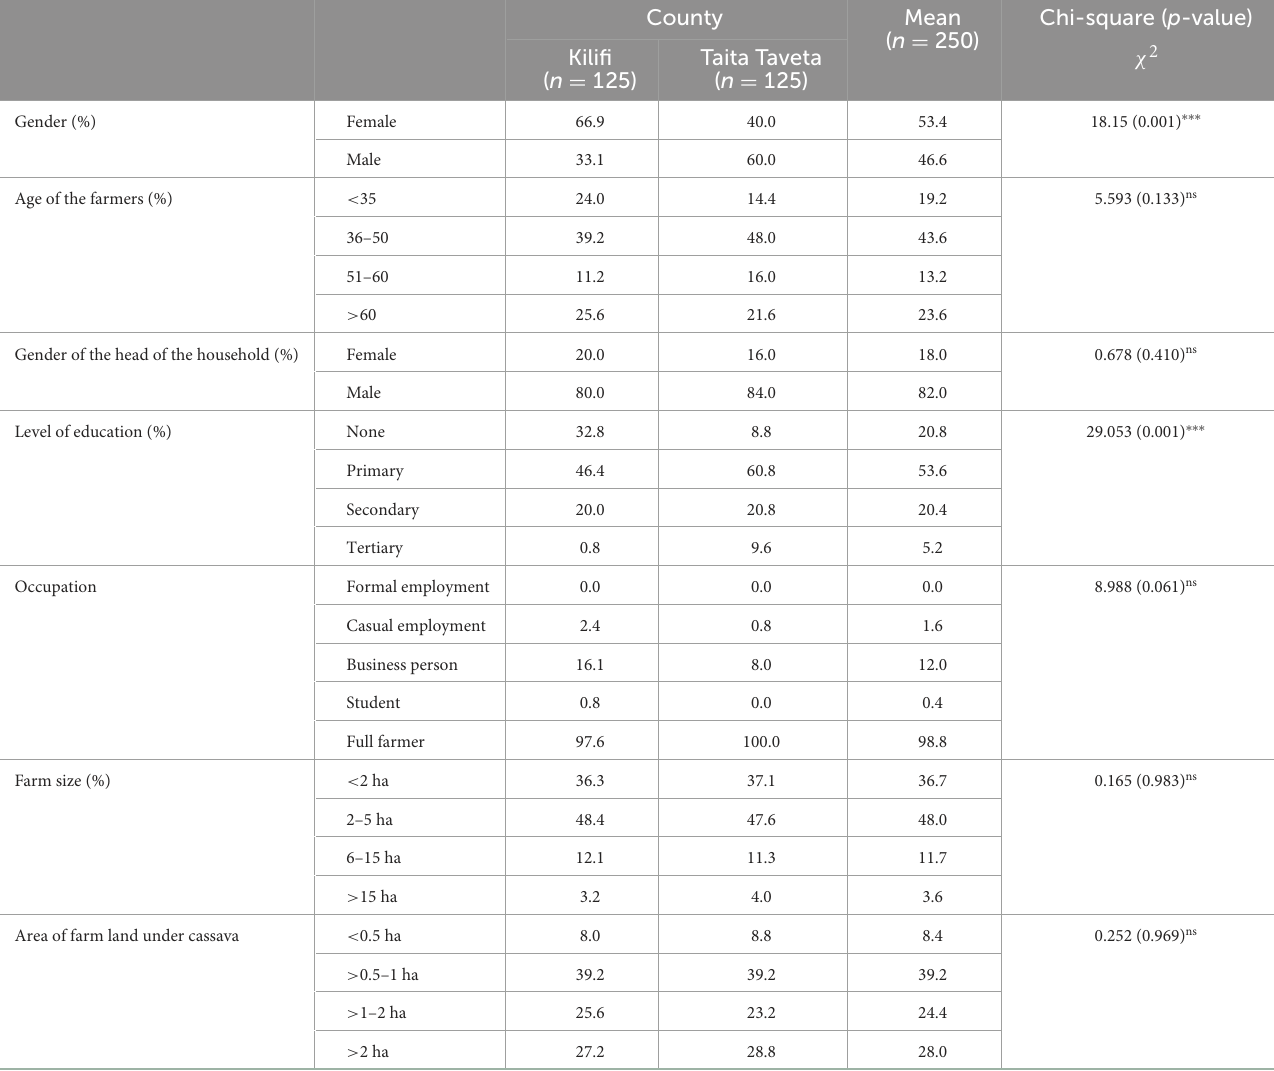
TABLE 1 Characteristics of the respondents (farmers surveyed; n = 250) in Kilifi and Taita Taveta